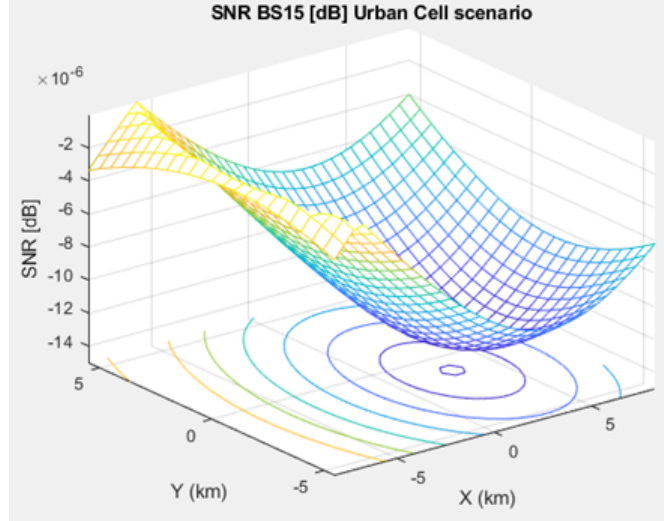
Figure 9. SNR for BS No. 15 in urban macrocell